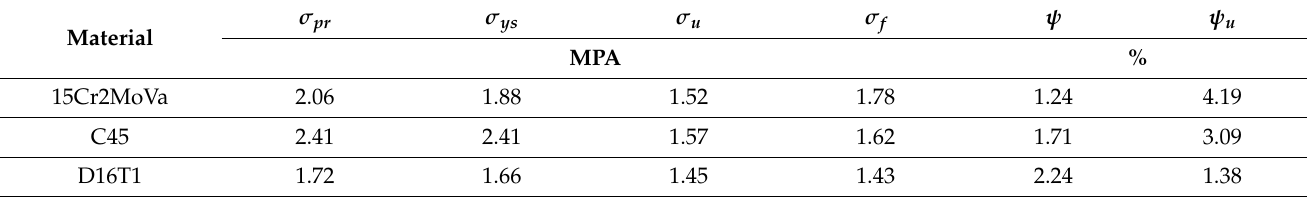
Table A4. Coefficient K values of relative measures of the key mechanical